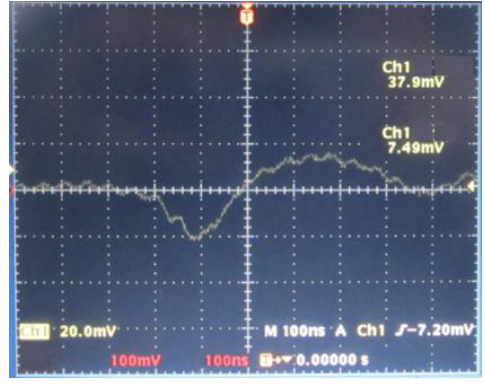
Figure 12. The waveform of the FE signal on the